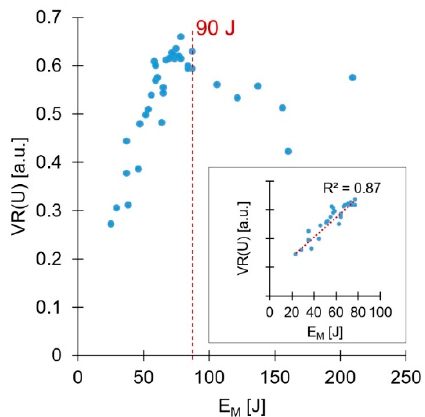
Figure 13. Correlation between improved volumetric ratio, VR(U), and total energy input (E M ). In detail, correlation for the energy efficient range (E M ≤ 90 J).